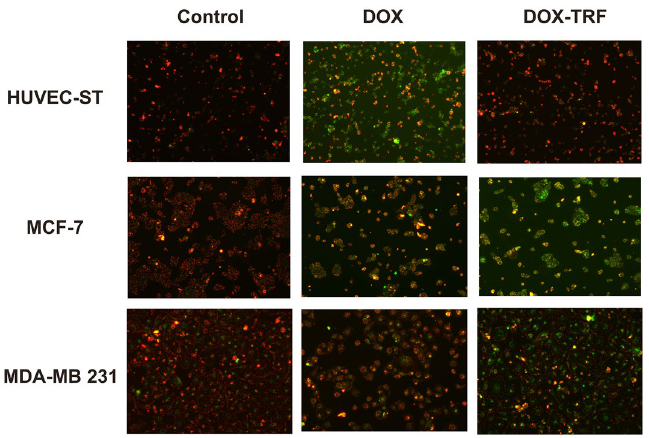
Figure 5. Fluorescent microscopy images of control cells incubated with PBS, and cells treated with IC 50 concentrations of DOX or DOX–Tf for 24 h. Red fluorescence of JC-1 dimers was present in the cell areas with high MMP, while green fluorescence of JC-1 monomers was prevalent in the areas with diminished MMP. JC-1-stained cells were visualized with an inverted fluorescence microscope (Olympus IX70, Japan); 400 × magnification.